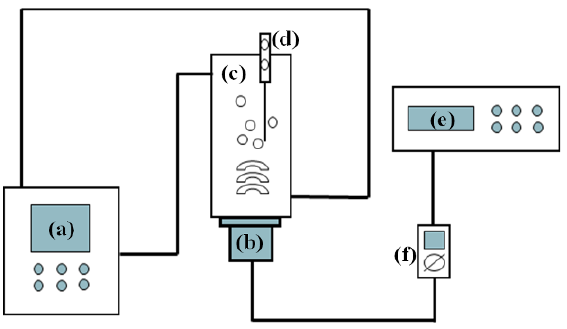
Figure 1. Schematic of the experimental reactor setup: (a) cooling system, (b) transducer, (c) reactor, (d) thermometer, (e) ultrasound generator, and (f) power